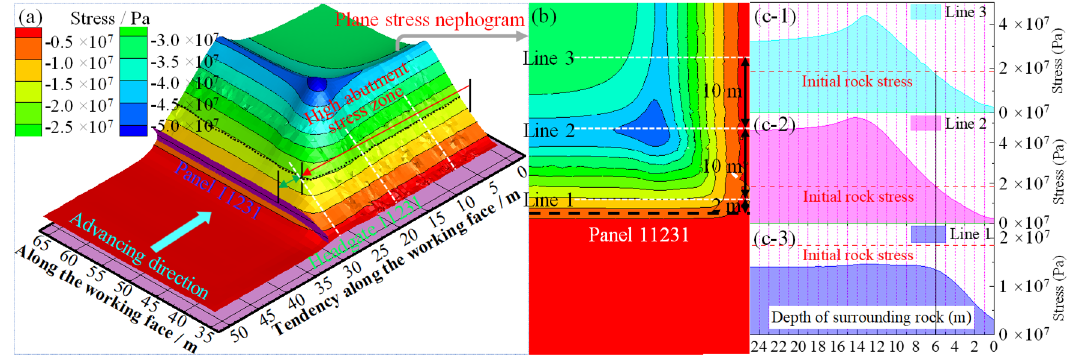
Figure 15. Distribution law of abutment stress in front of panel 11231. ( a ) 3D stress distribution of roadway rib; ( b ) Line layout; ( c-1 ) 22 m in front of the panel ( c-2 ) 12 m in front of the panel; ( c-3 ) 2 m in front of the panel.